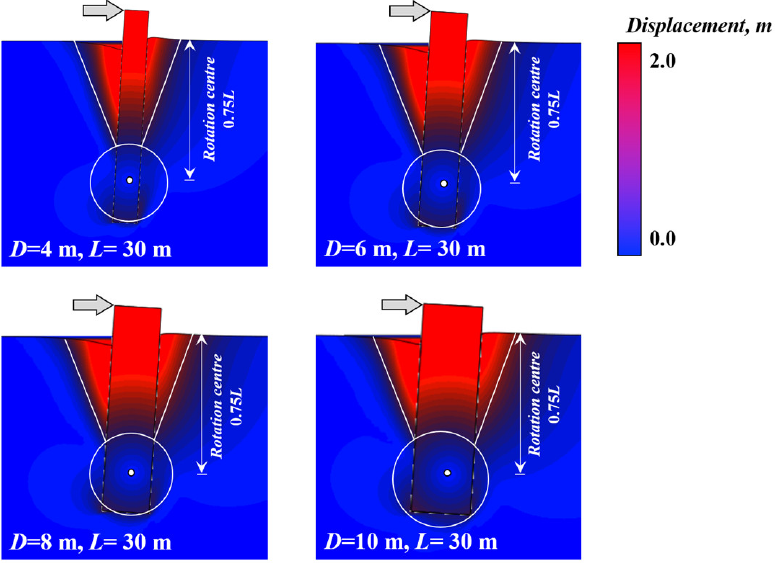
Figure 11. Displacement contour of different diameter and aspect ratio monopiles under the same pile deflection in 65% relative density sand.